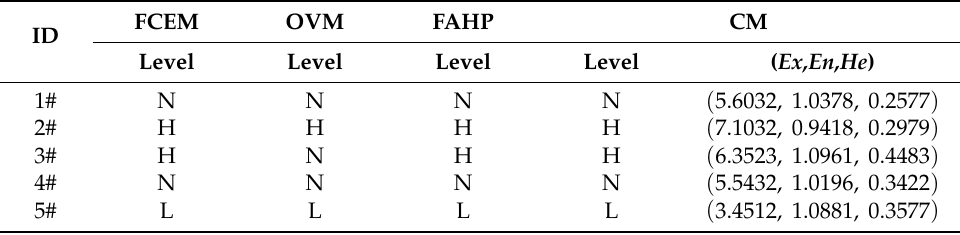
Table 7. Comparison of evaluation results by four different methods.